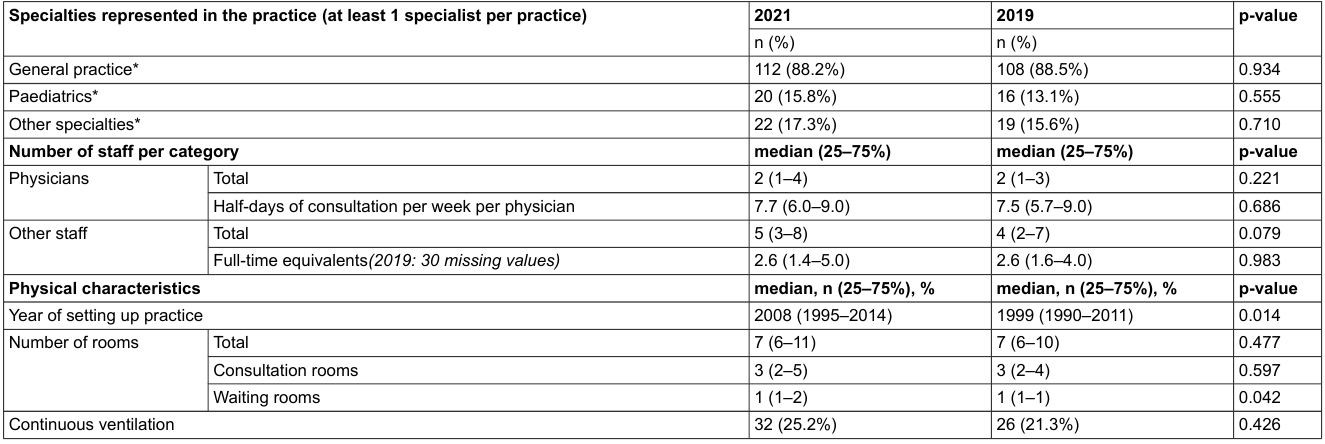
Table 1: Practice characteristics in the Sentinella network in 2021 and 2019 (127 and 122 answering practices, respectively). Specialties represented in the practice (at least 1 specialist per